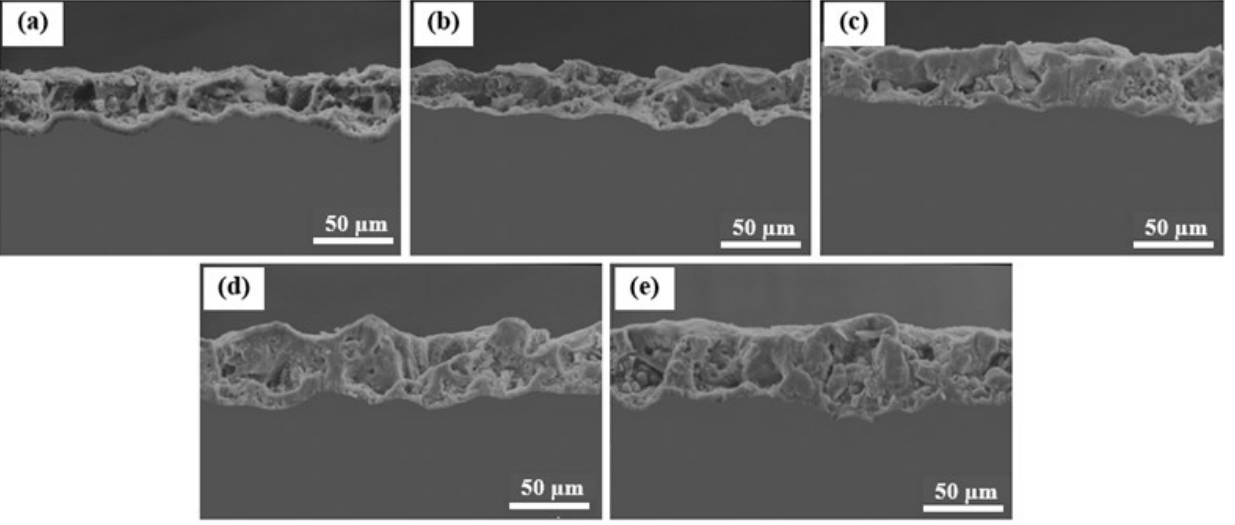
Figure 4. FE-SEM images of cross section at various concentrations of TiO 2 : 0 ( a ), 1 ( b ), 2 ( c ), 3 ( d ), and 4 ( e )